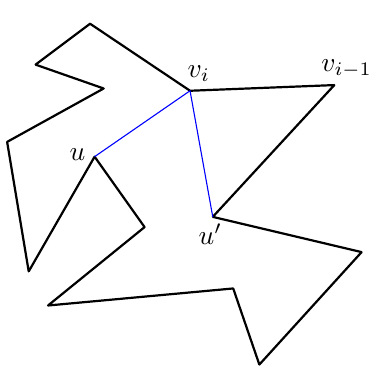
Figure 2: Since u (cid:48) ∈ C ( u, v i ) , v i u (cid:48) lies counterclockwise between v i u and v i v i − 1 .